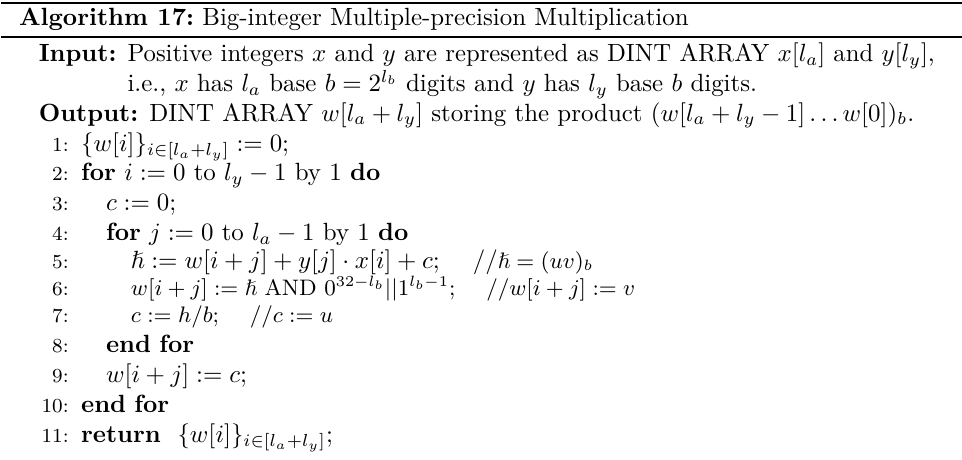
Algorithm 17: Big-integer Multiple-precision